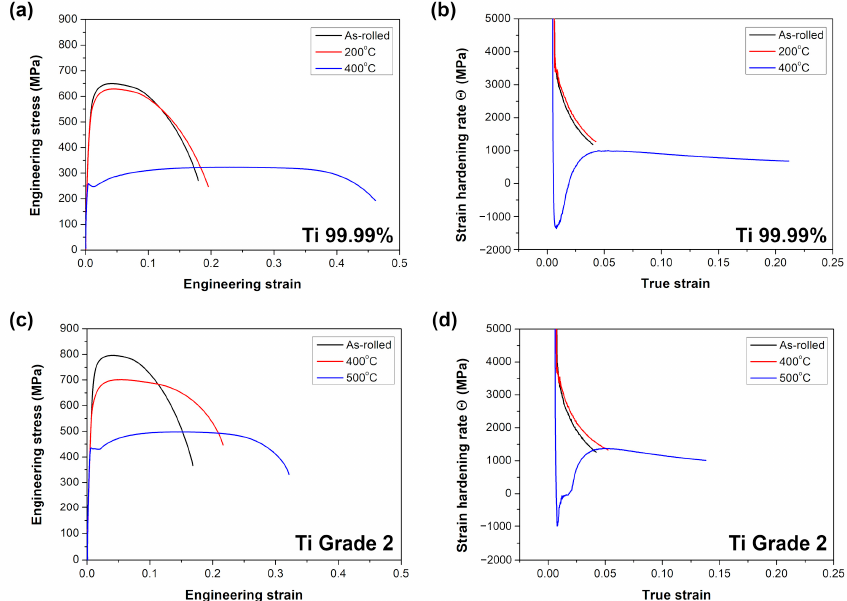
Figure 5. Stress–strain curves and strain-hardening rate Θ versus true strain for ( a , b ) Ti 99.99% and ( c , d ) Ti Grade 2. Table 2. Mechanical properties of the as-rolled and annealed Ti 99.99% and Ti Grade 2 (YS—0.2%